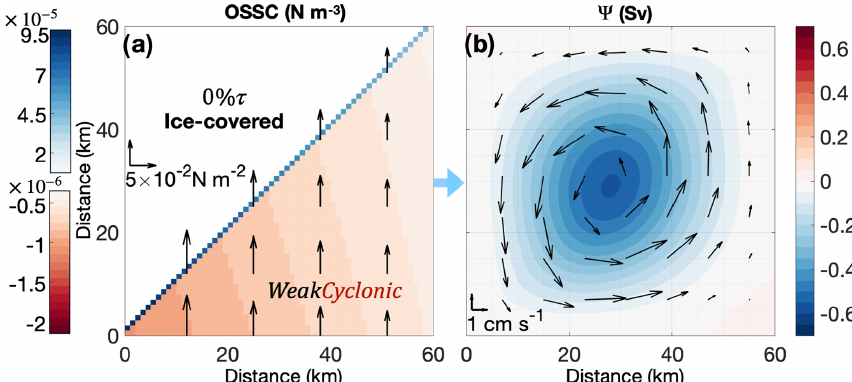
Figure 9. Ocean surface stress curl (OSSC) and simulated gyre streamfunction ( (cid:57) ) for simulation with the WeakCyclonic wind field and the SeaIce π and 0% τ ice coverage. (a) Shading indicates OSSC, and arrows indicate wind stress (only every 13th arrow is plotted for clarity). 4 (b) Shading indicates simulated gyre (cid:57) , and arrows indicate current velocity (only every eighth arrow is plotted for clarity).